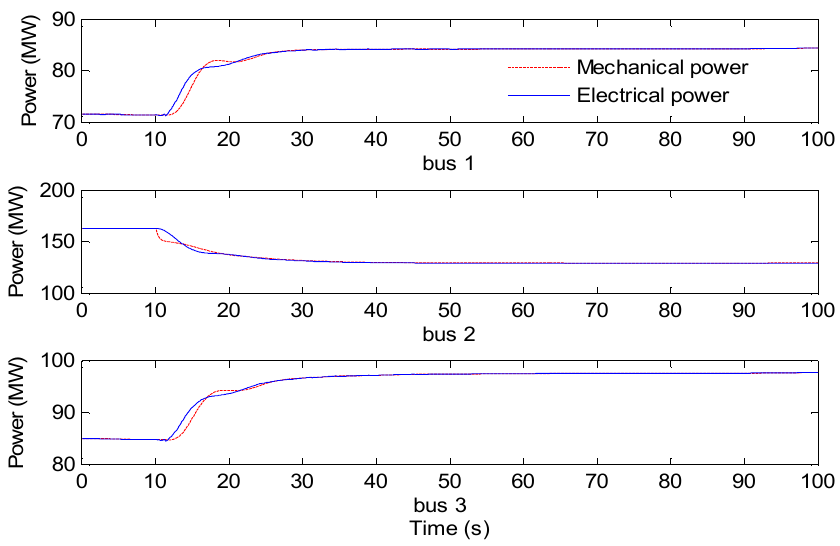
Figure 14. Mechanical power and electrical power at generator buses 1, 2 and